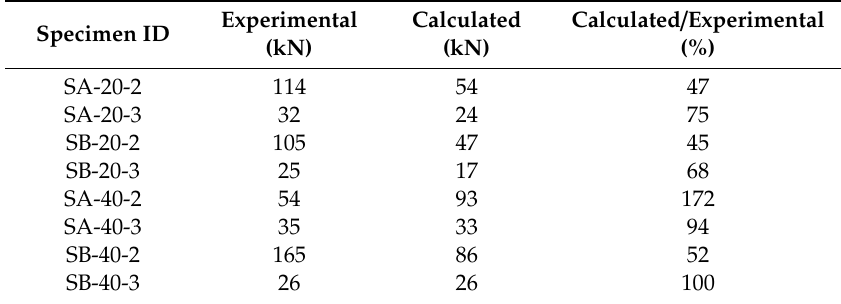
Table 4. Experimental and calculated